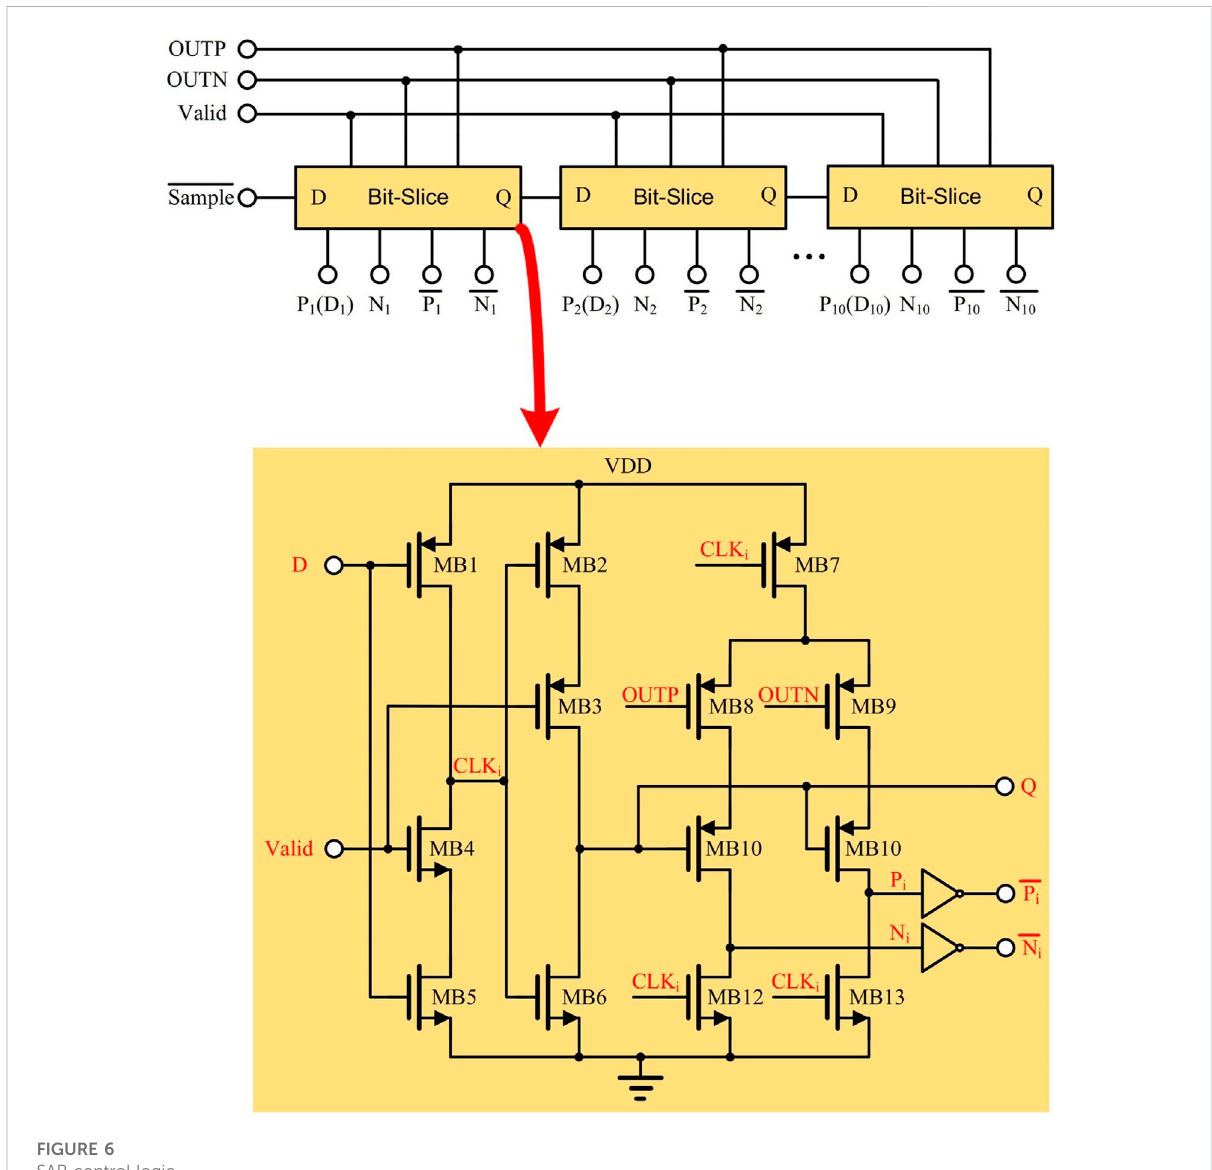
FIGURE 6 SAR control